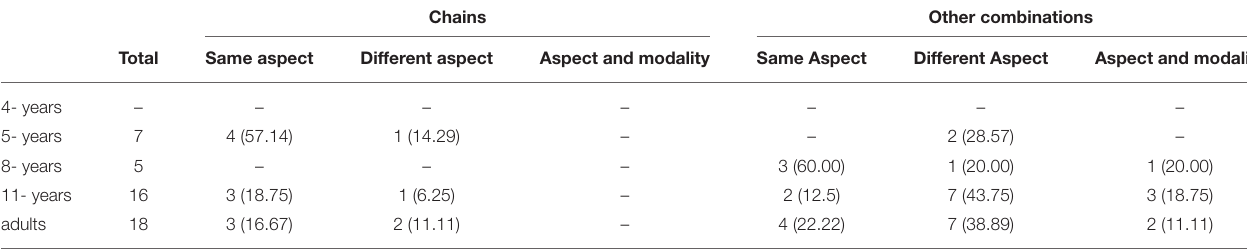
TABLE 8 | Frequency (and percentage) of 2-NCL and 3-NCL complex sentences in terms of type of aspect by age. Chains Other combinations Total Same aspect Different aspect Aspect and modality Same Aspect Different Aspect Aspect and modality